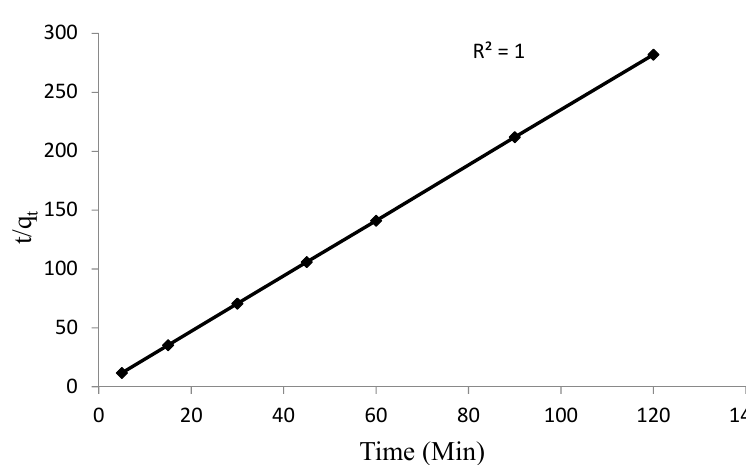
Figure 9. Pseudo first order kinetics for Pb 2+ adsorption onto synthesized chitosan.